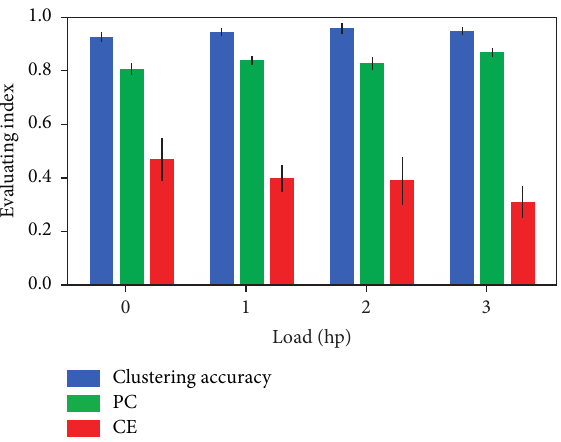
Figure 10: The performances of the proposed method under different loads. Table 5: The recognition results of different